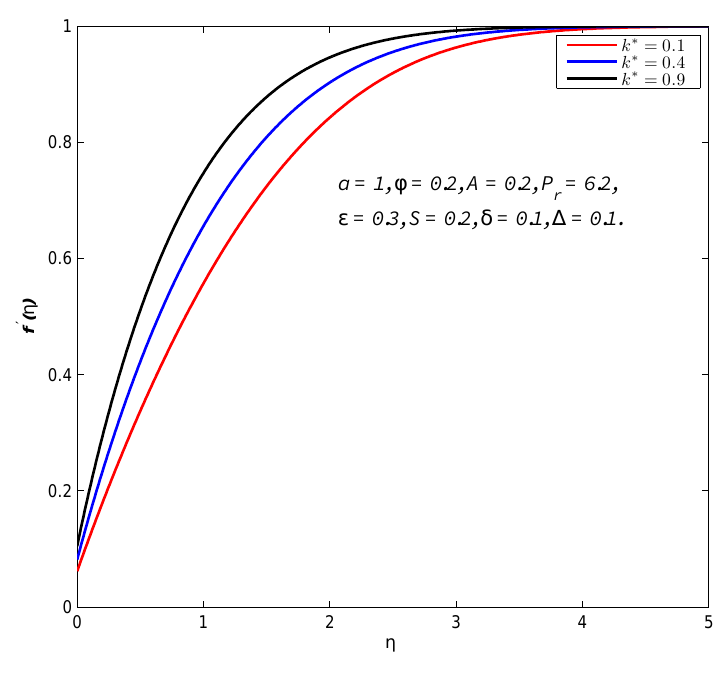
Figure 3. Velocity f (cid:48) ( η ) profiles for different values of permeability parameter k ∗ .